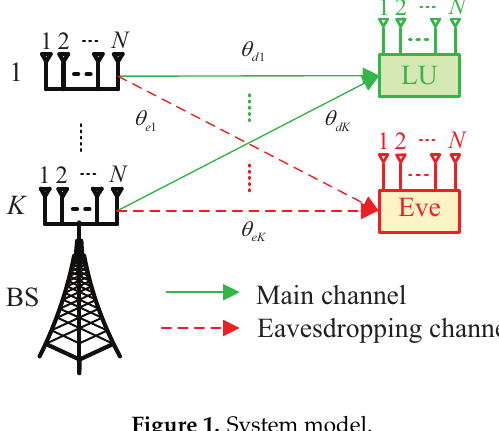
Figure 1. System